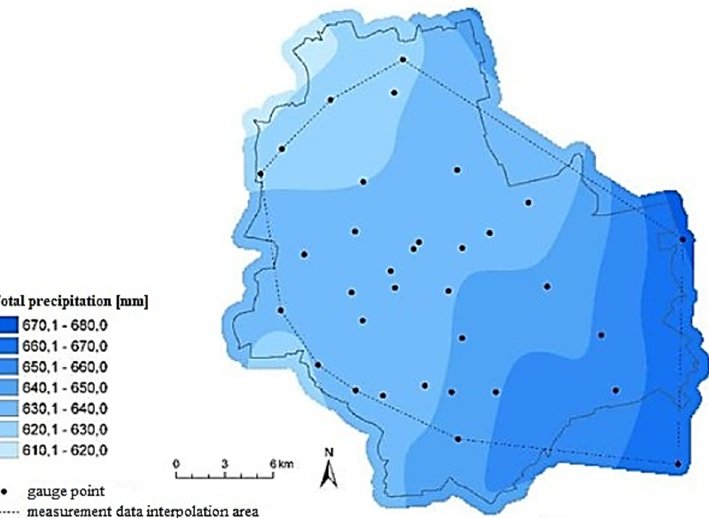
Figure 4. Total annual precipitation in the city of Warsaw—averaged over the period 2008–2014 (Source: Department of Geoecology and Climatology IGiPZ PAN).